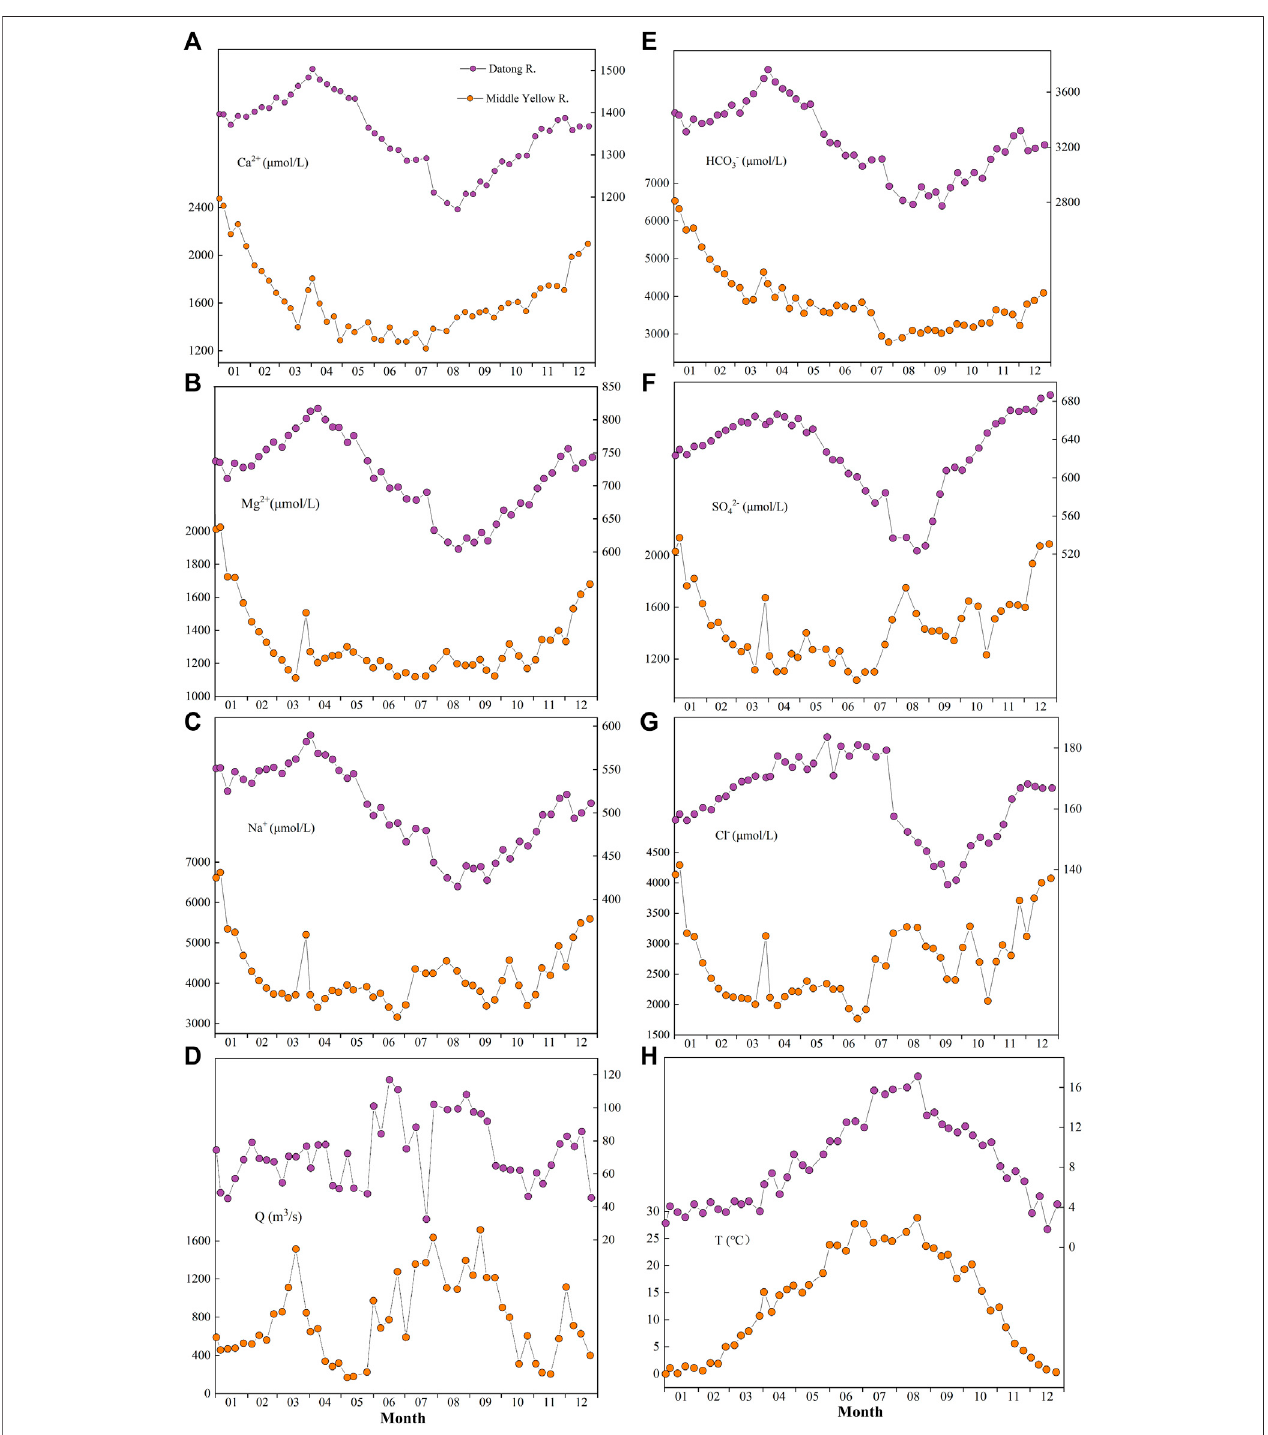
FIGURE 5 | Comparisons of seasonal variations of (A) Ca 2+ , (B) Mg 2+ , (C) Na + , (D) Runoff, (E) HCO 3 − (F) SO 42 − , (G) Cl − , and (H) Water temperature between the upstream and midstream of the Yellow River. The time-series data of the upstream (purple) are the Datong River (this study). The weekly data of the midstream (orange) are from Zhang et al. (2015).